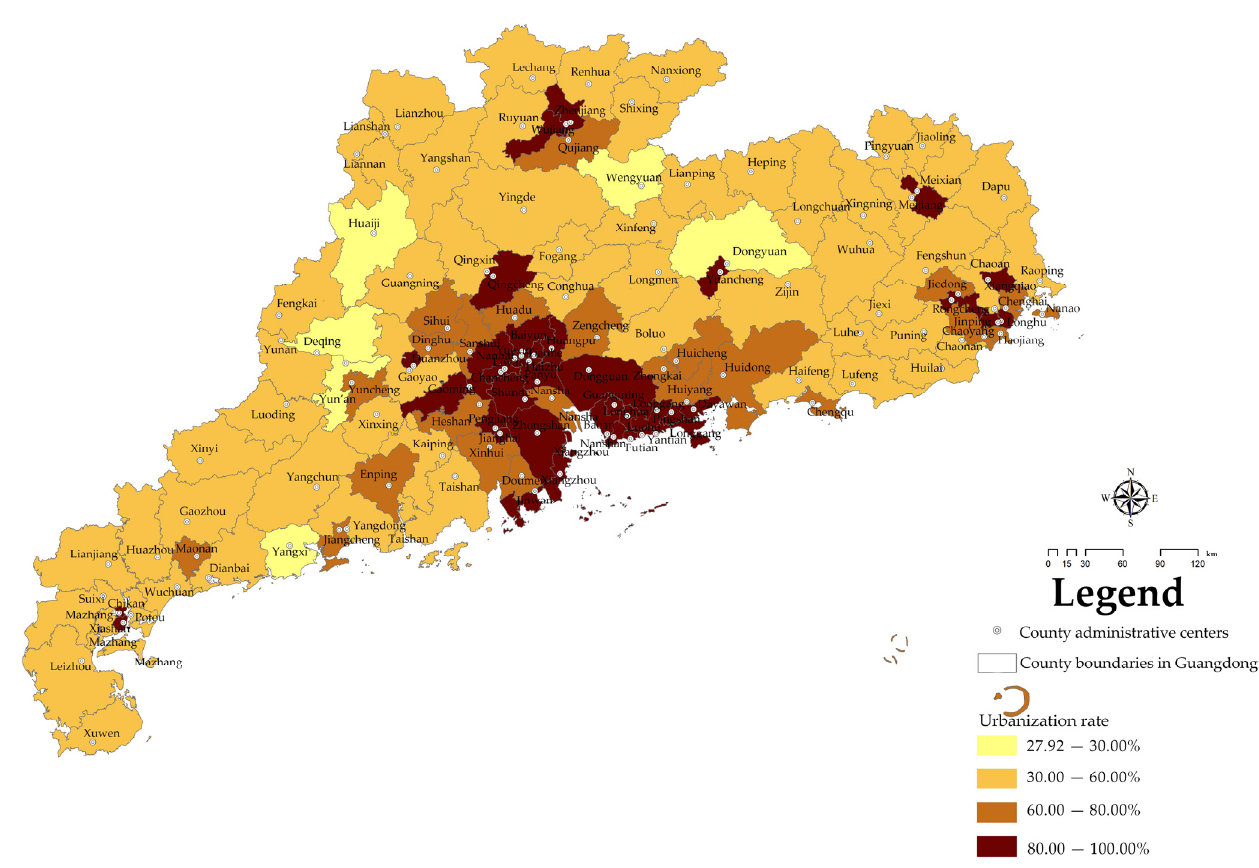
Figure 6. Hierarchical distribution of urbanization rate.